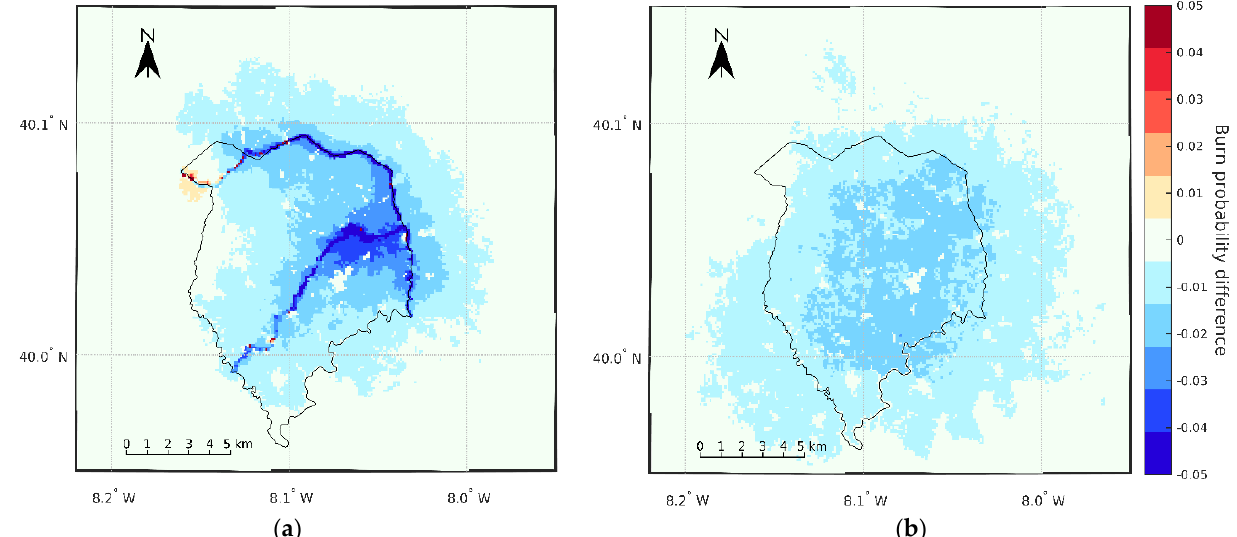
Figure 10. Impact of increased fuel management on estimated burn probability compared to the BAU option: ( a ) 1/3 of the fuel break network and ( b ) a moderate increase in the managed forest area.